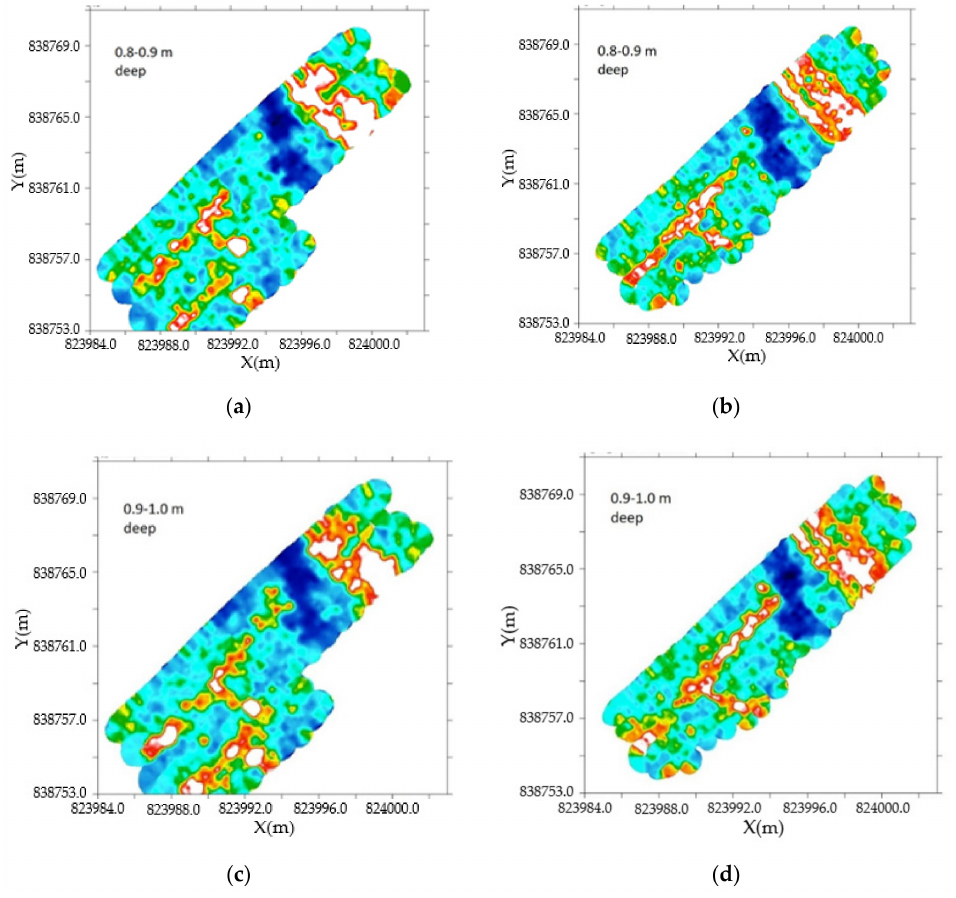
Figure 14. ( a , c ) C-scans of method T2; ( b , d ) C-scans of method T3; ( a , b ) for a depth of 0.8–0.9 m; ( c , d ) for a depth of 0.9–1.0